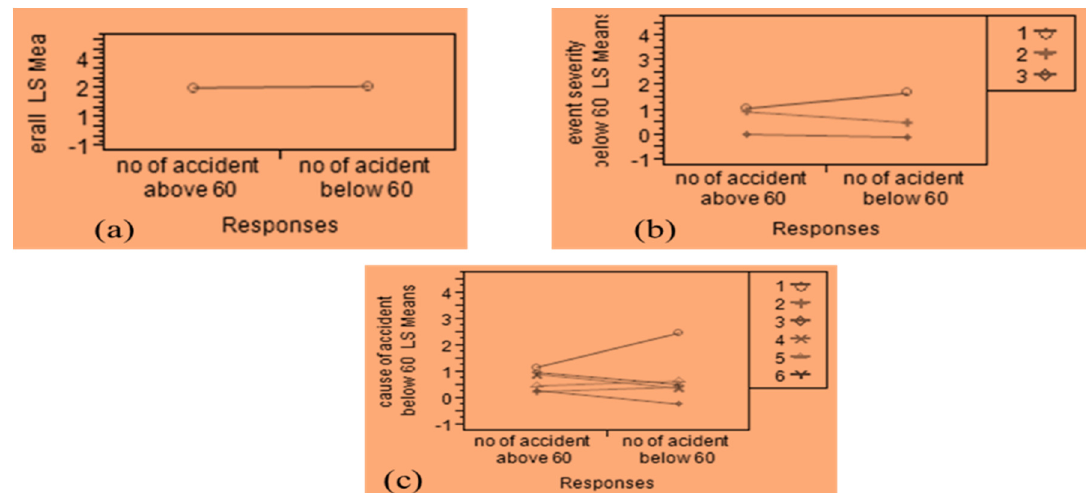
FIG..4: MANOVA (a) OVERALL MEAN AND DIFFERENCE IN NUMBER OF ACCIDENTS BELOW 60 WITH REPSECT TO (b) SEVERITY AND c) CAUSE OF ACCIDENT